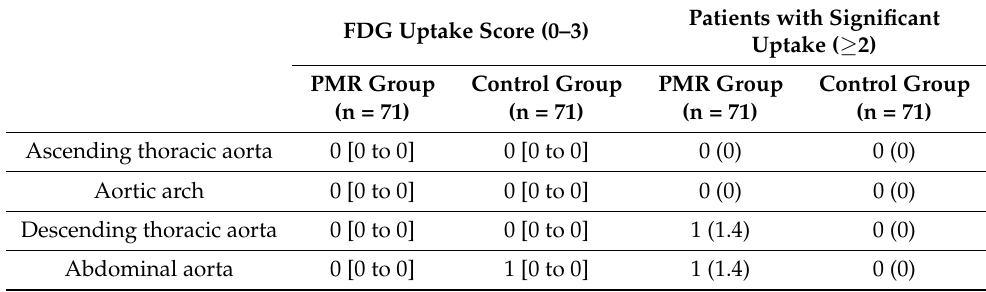
Table 5. FDG-PET/CT results according to location (vascular